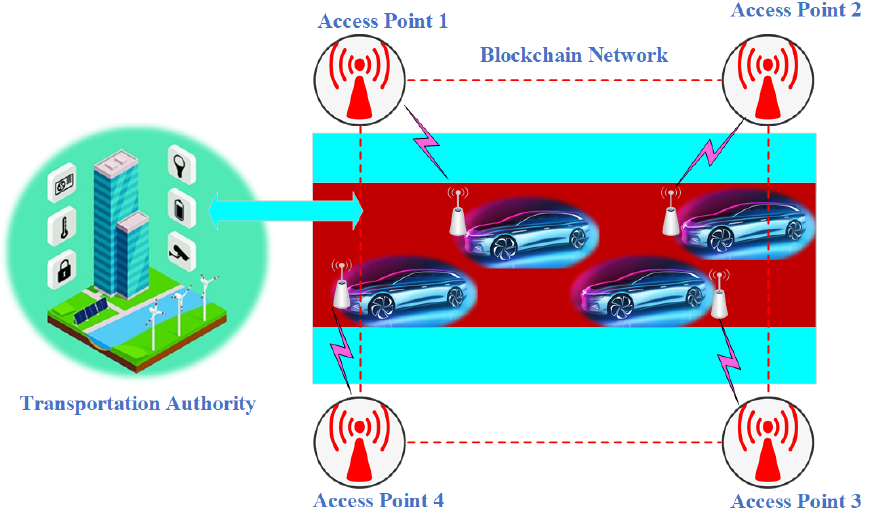
Figure 5. Blockchain architecture of EV applications.